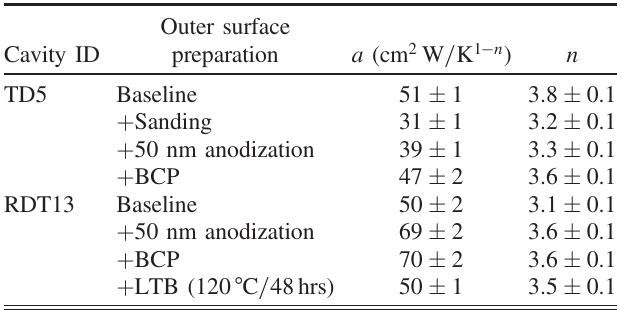
TABLE II. The fit coefficients from the power law R B ¼ aT − n . Cavity